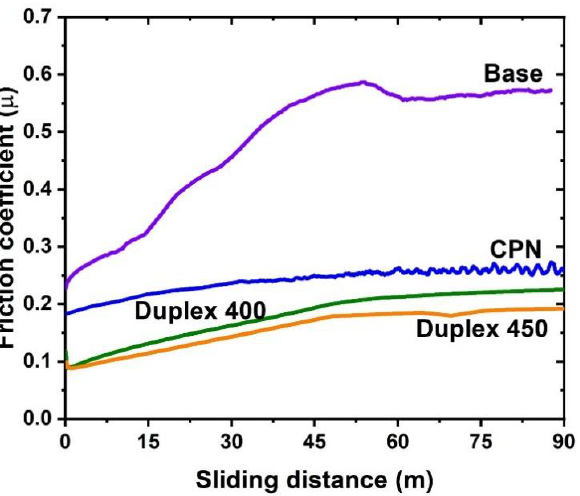
Figure 9. Variation of friction coefficient with sliding distance of base sample, CPN, and duplex- treated samples with substrate temperature for TiN deposition at 400 °C and 450 °C.